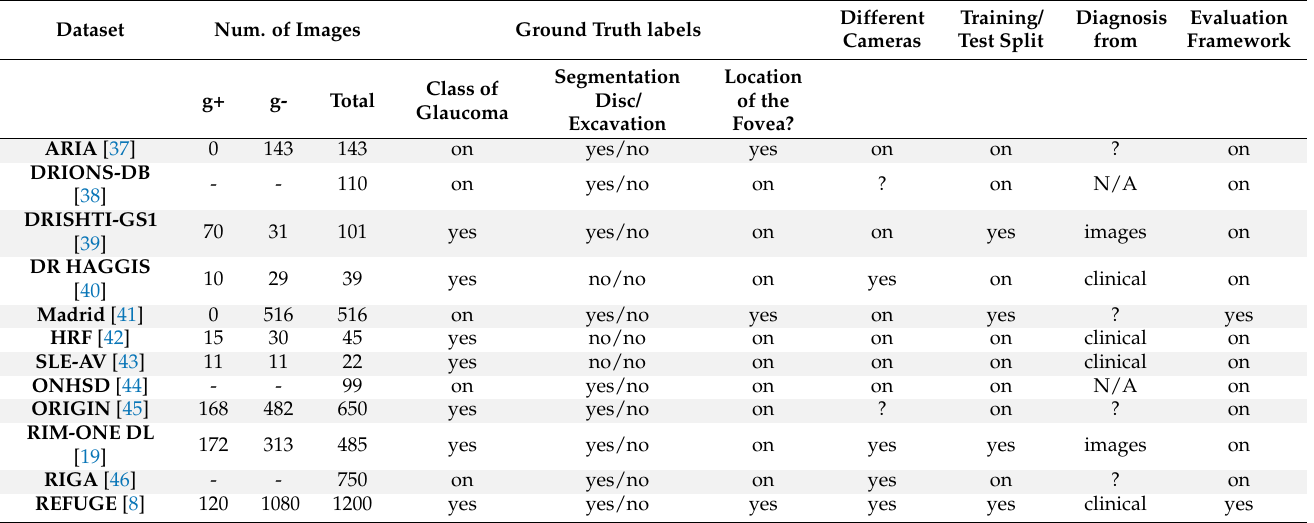
Table 1. Comparison of the dataset with other publicly available databases of background images. Question marks indicate missing information, and N/A means “not applicable”. Adapted from